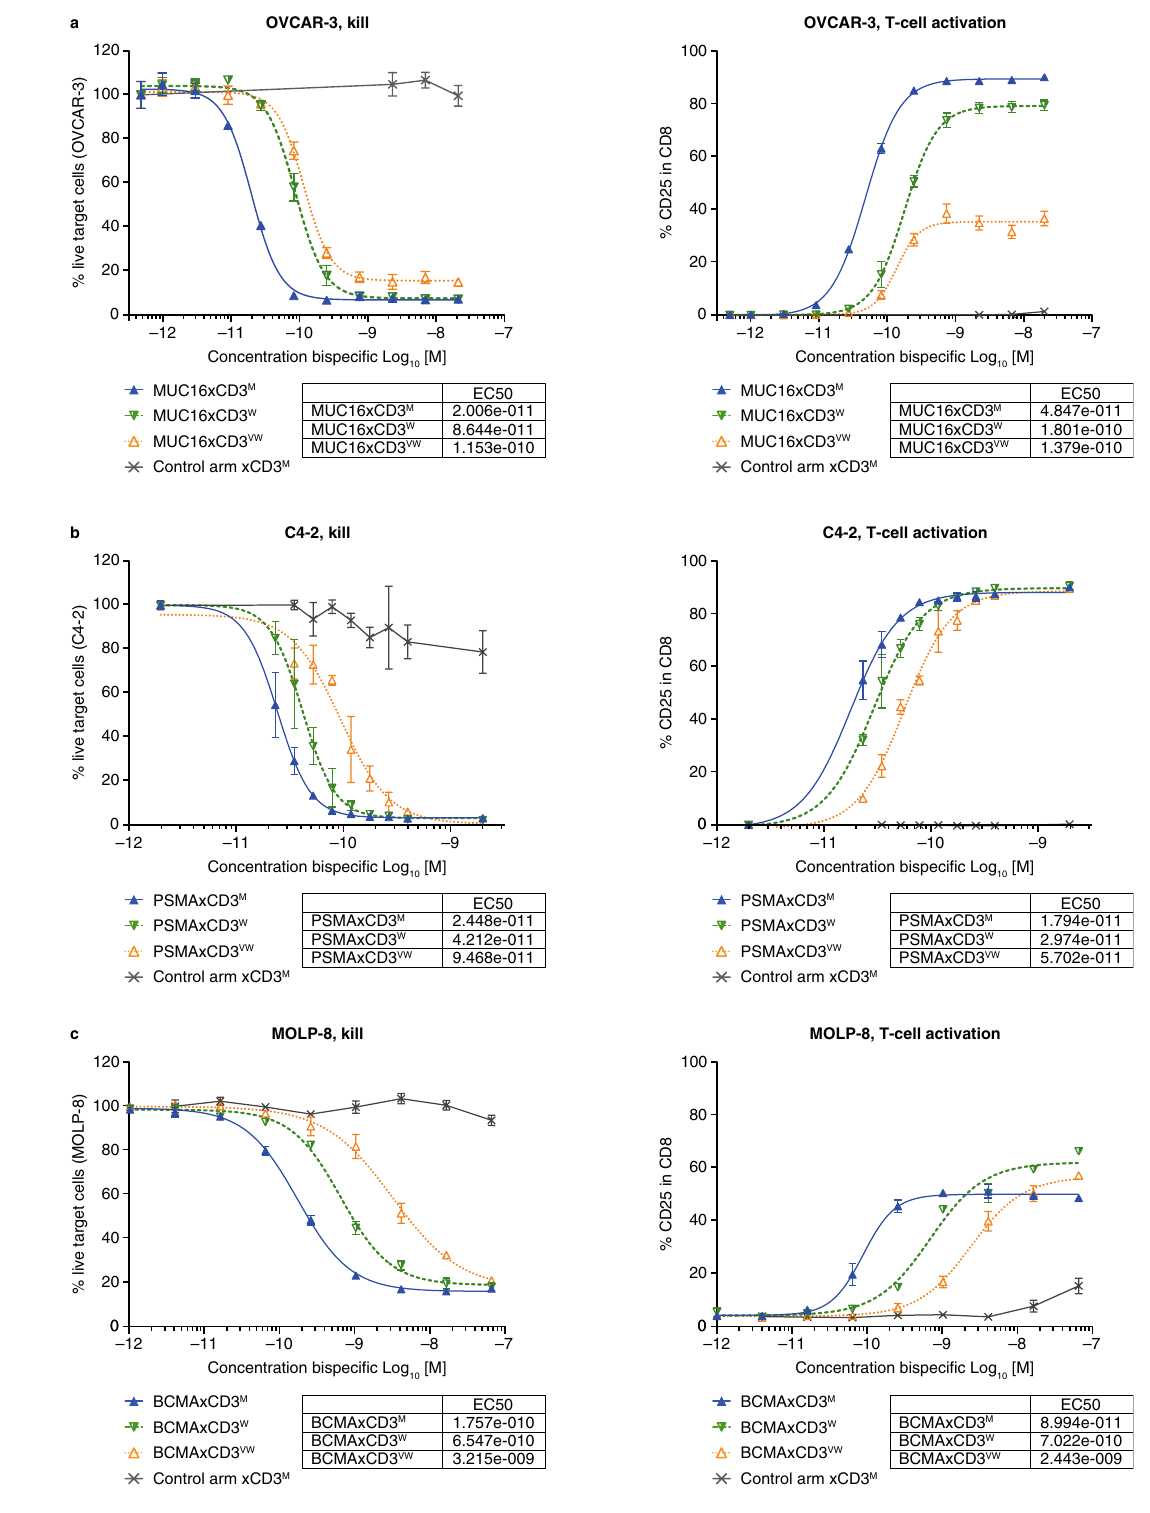
Figure 4. CD3-based bispecific antibodies are cytotoxic to tumor cells expressing the tumor antigen of interest, and the in vitro potency is driven by the strength of the CD3 arm. T-cell activation and cytotoxic potency of bispecific antibodies of various CD3 strengths were evaluated across various programs. The cytotoxic potency and T-cell activation induced by MUC16xCD3, PSMAxCD3, and BCMAxCD3 bispecific antibodies was evaluated against OVCAR-3 ( a ), C4-2 ( b ), and MOLP-8 ( c ) cells in the presence of human PBMCs, respectively (data representative of two independent experiments, three replicates). BCMA B-cell maturation antigen; EC50 half maximal effective concentration; m , moderate; MUC16 Mucin-16 for ovarian cancer; PSMA prostate specific membrane antigen; vw very weak; w